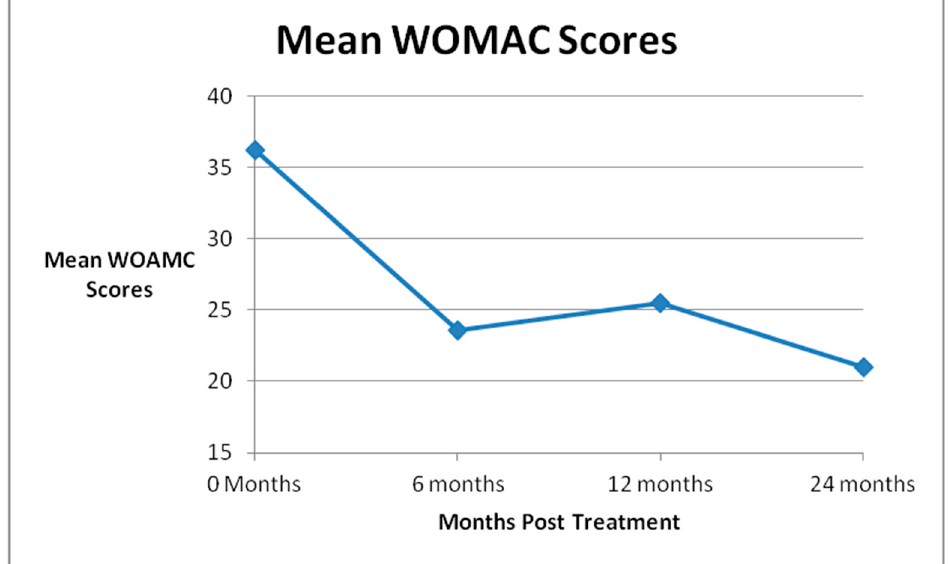
Figure 3. Mean Knee injury and Osteoarthritis Outcome Score Physical Shortform (KOOS-PS) Scores.